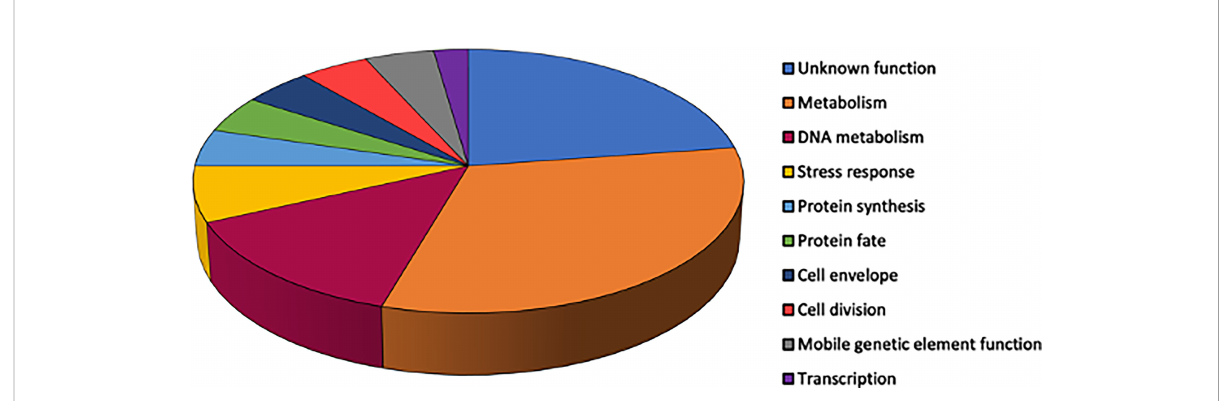
FIGURE 4 Relative proportions of functional groups ascribed to S. aureus genes with identi fi ed sequence variants across three serial nasopharyngeal passages. Variants were included for non-synonymous intragenic SNPs